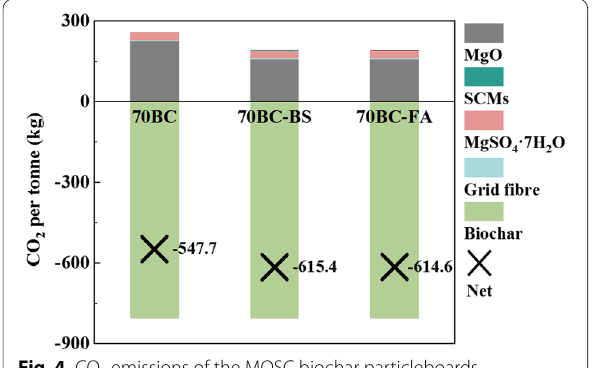
Fig. 4 CO 2 emissions of the MOSC biochar